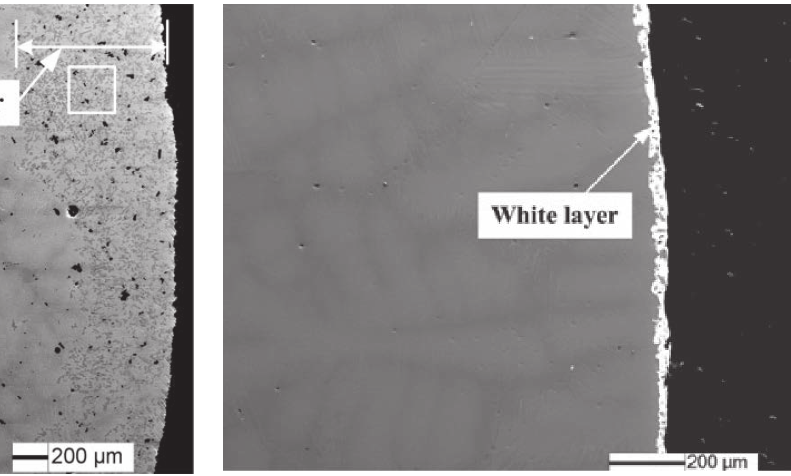
Fig. 3: SEM micrograph of the Ti-47Al-2Cr-2Nb sample obtained by yttria mould.